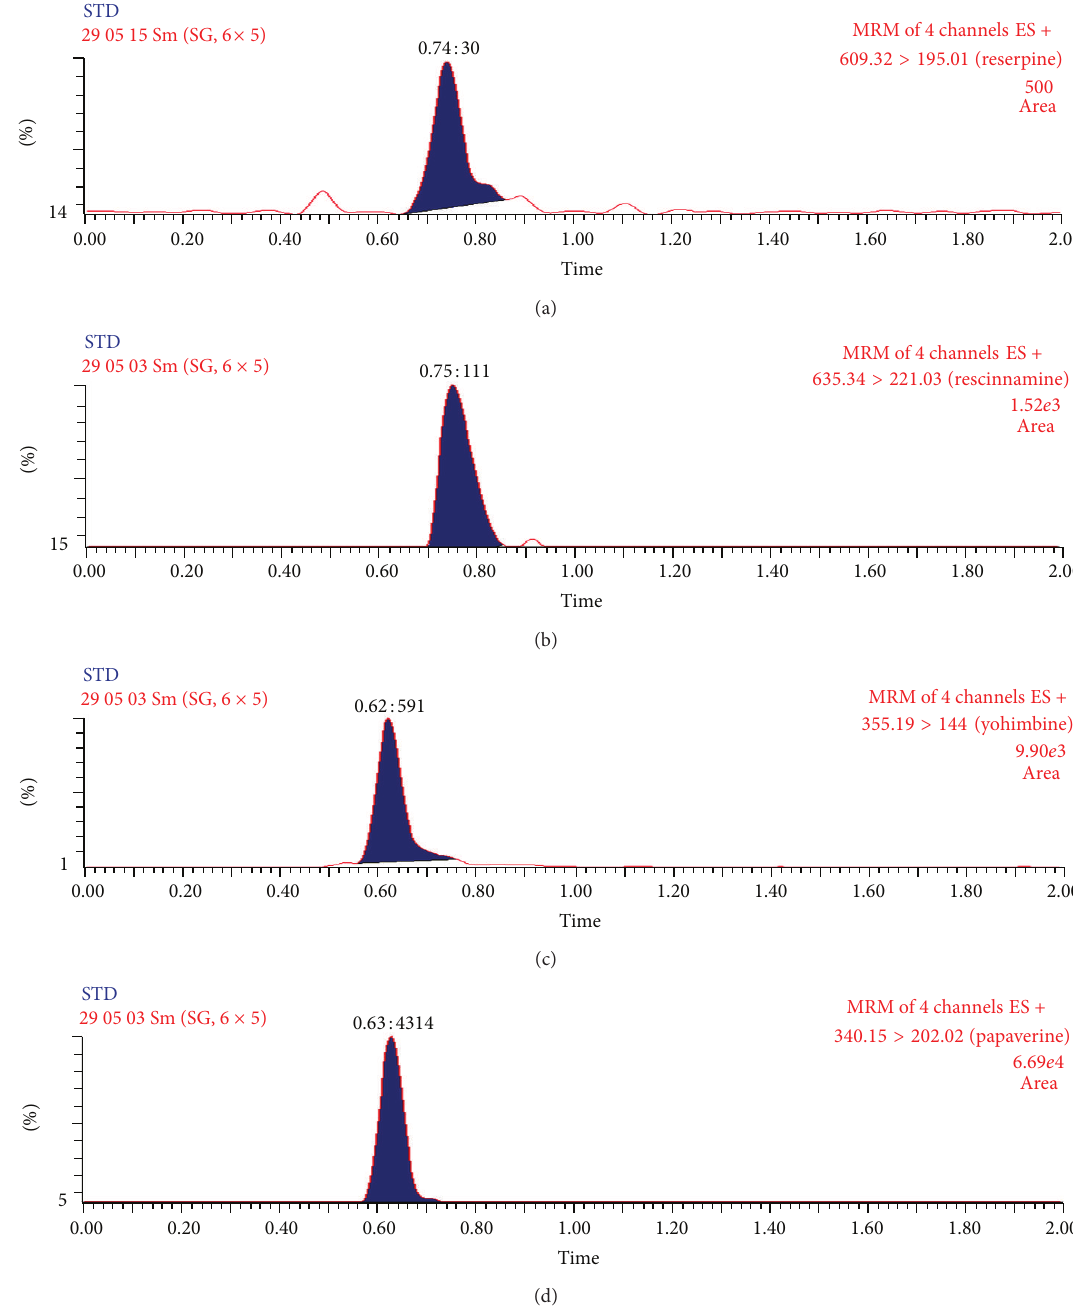
Figure 5: Representative MRM chromatograms at LLOQ level of reserpine (a), rescinnamine (b) yohimbine (c) and papaverine (d).